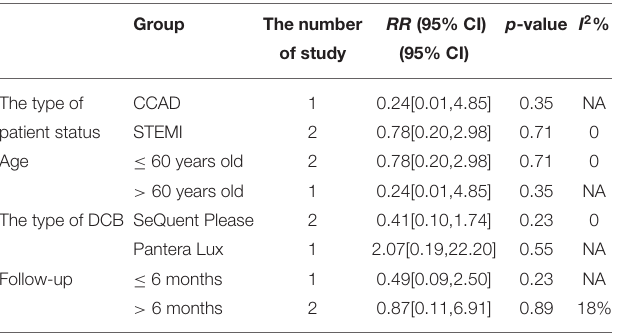
TABLE 3 | The subgroup analysis of TLR.